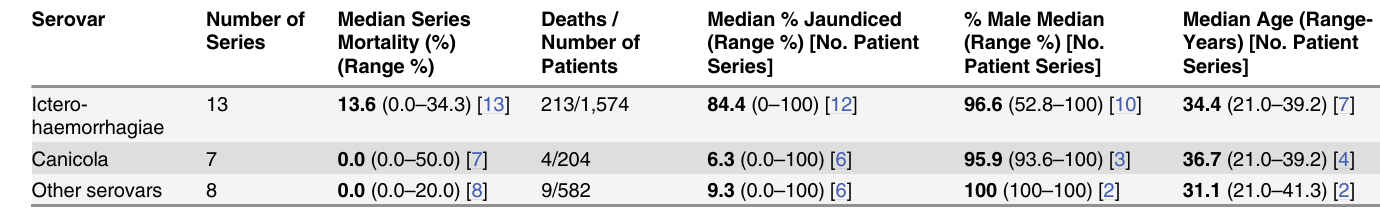
Table 4. Mortality according to